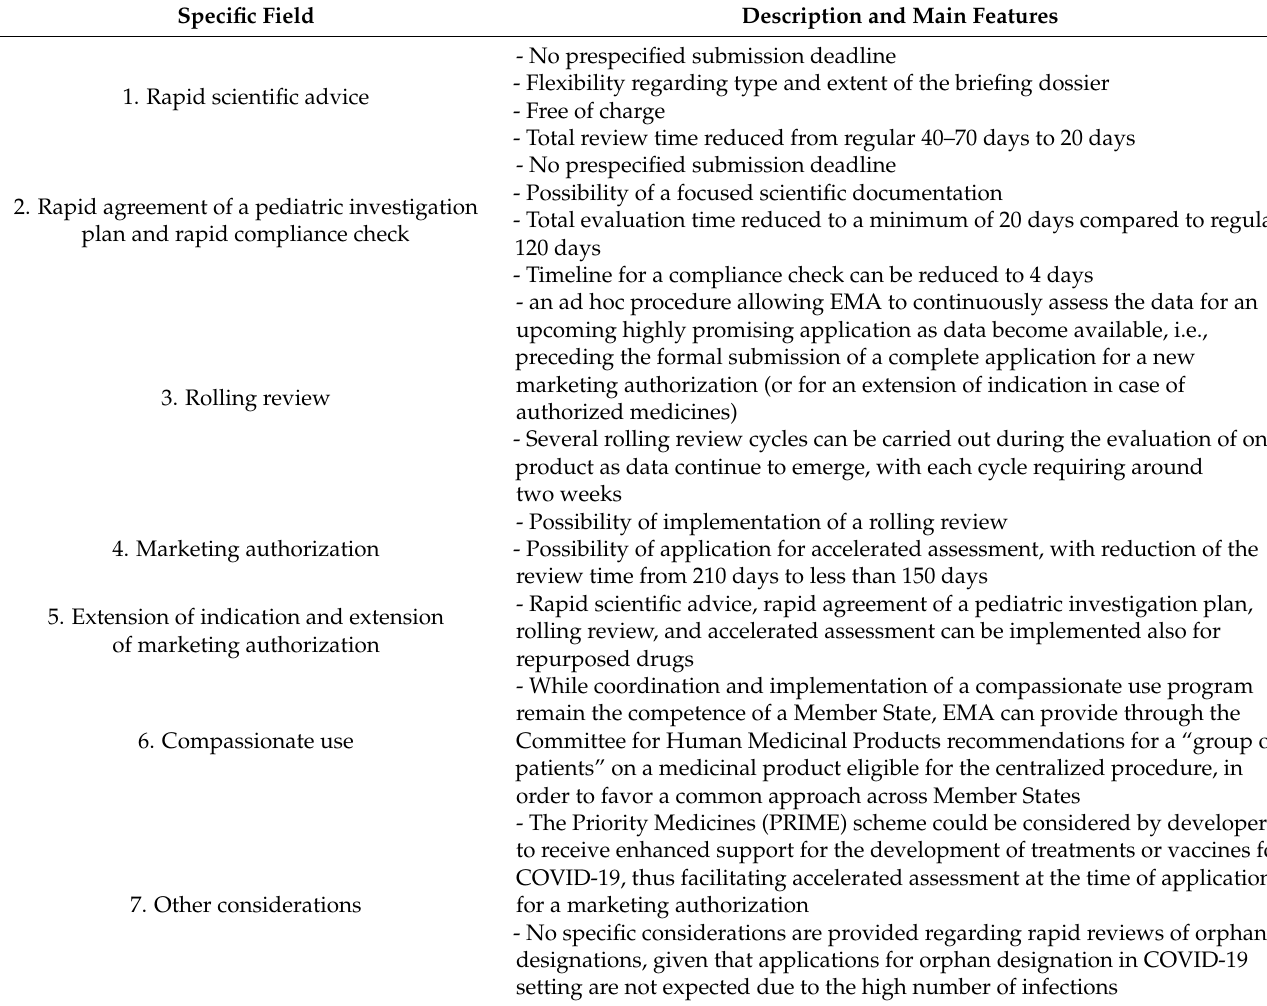
Table 2. Specific initiatives for acceleration of development support and evaluation procedures for COVID-19 treatments and vaccines implemented by the European Medicines Agency